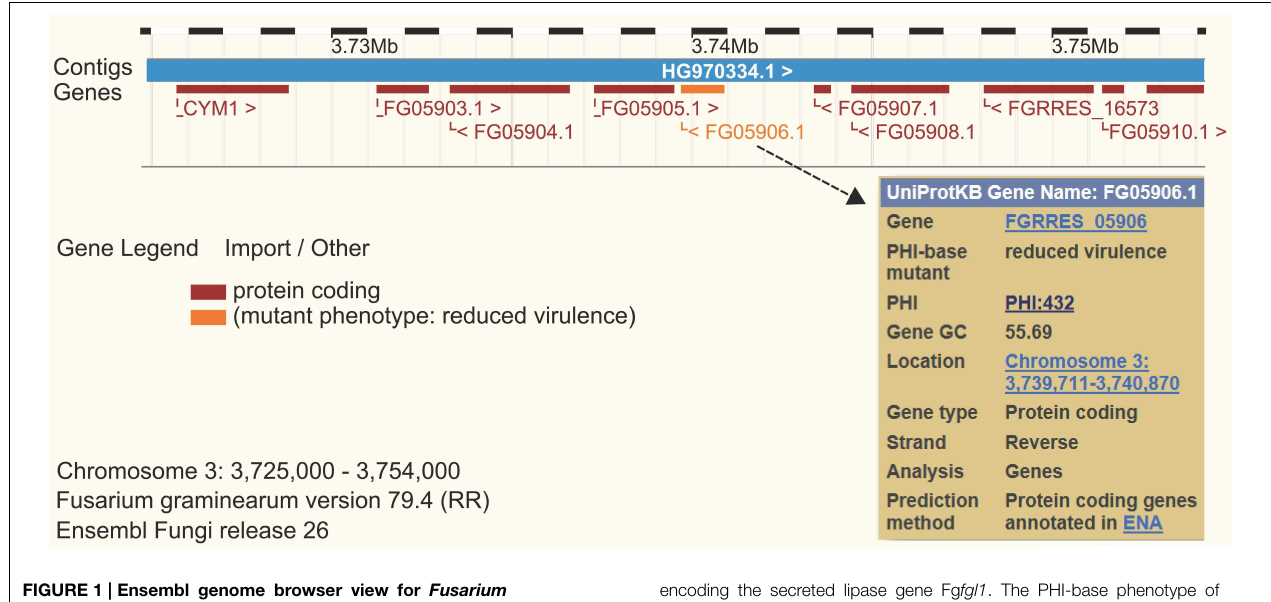
FIGURE 1 | Ensembl genome browser view for Fusarium graminearum. The website at http://fungi.ensembl.org/ Fusarium_graminearum was searched for the gene id FGSG_05906 virulence.”